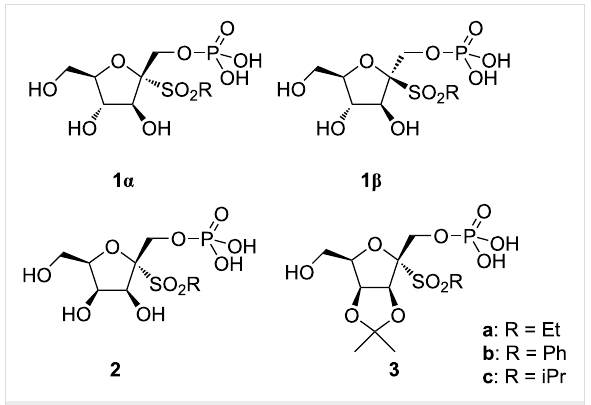
Figure 1: Target ᴅ -fructofuranosyl and ᴅ -tagatofuranosyl sulfones 1 ‒ 3